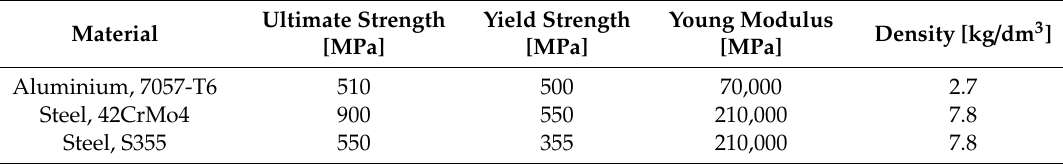
Figure 1. The double-acting hydraulic cylinder assembly. Table 1. Material properties for the reference hydraulic